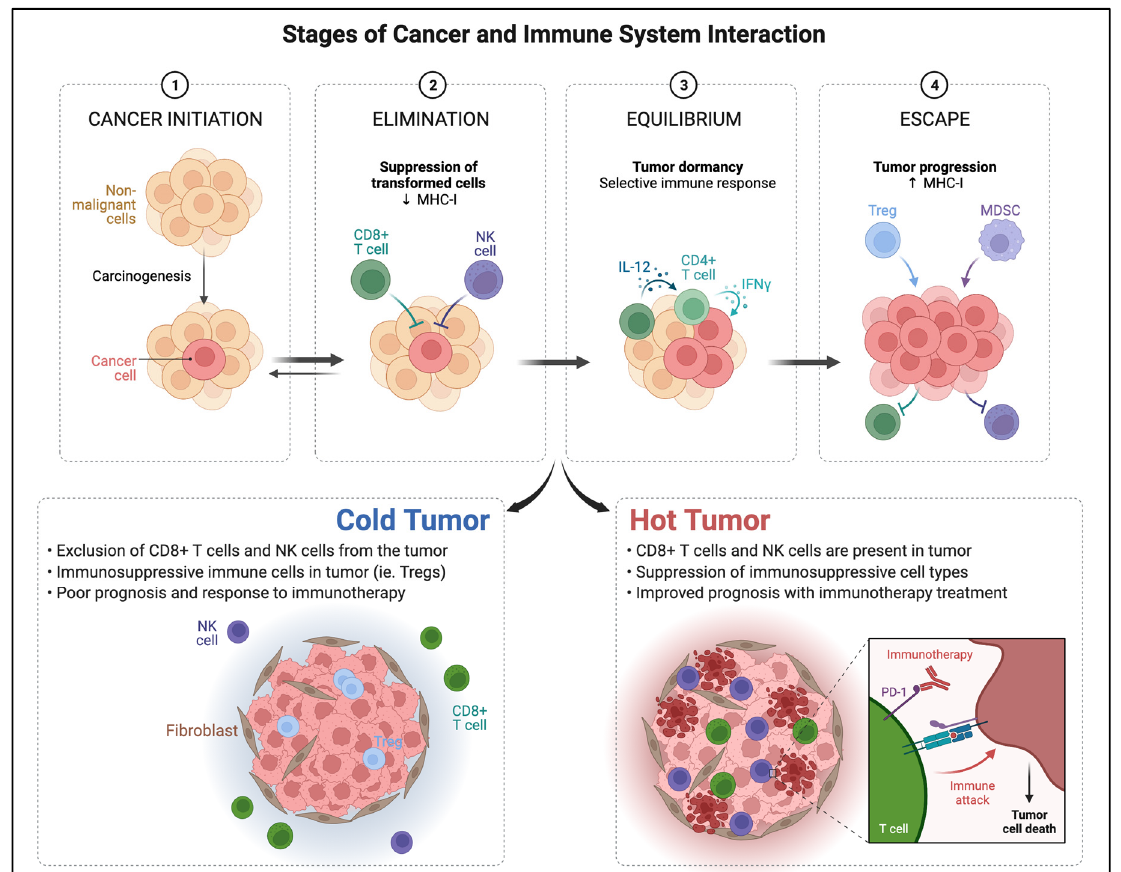
Figure 2. Outline of the stages of cancer and immune system interaction and tumor phenotypes classified by immunogenicity within the tumor microenvironment at the cellular level. Adapted from “Cancer Immunoediting” and “Cold vs. Hot tumors”, by BioRender.com (2022) (accessed on 28 March 2022). Retrieved from https://app.biorender.com/biorender-templates (accessed on 28 March 2022).